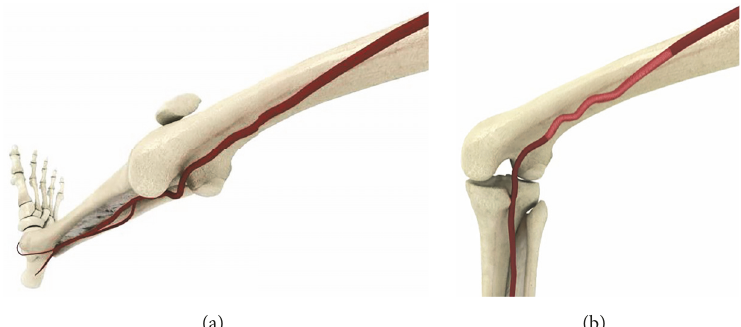
Figure 1: (a) Gentle curvature of the superficial femoral artery (SFA) with the leg extended. (b) With the knee flexed, the distal SFA adopts a helical pattern to accommodate vessel